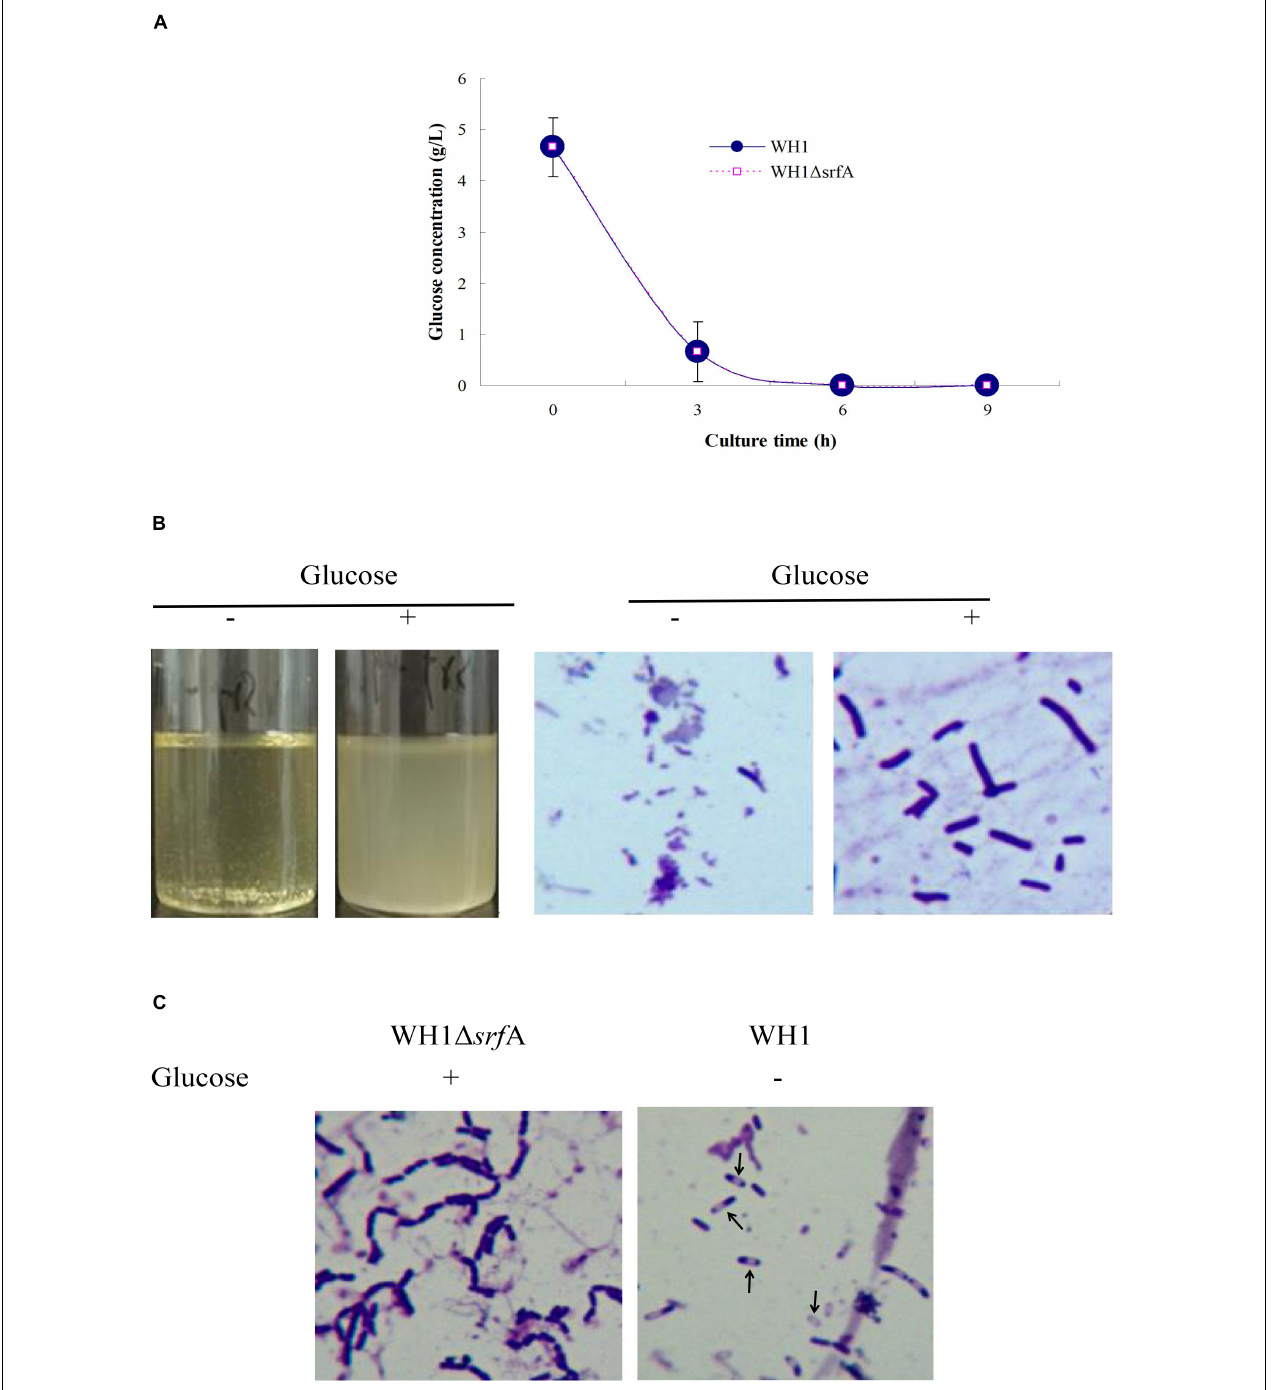
FIGURE 6 | Addition with glucose restored the growth of (cid:49) srfA in LB medium. (A) Residual glucose in LB medium. Both WH1 and (cid:49) srfA showed a similar profile to utilize the glucose in LB medium. (B) Addition with glucose (4 g/L) dramatically restored the growth of (cid:49) srfA in LB medium (magnification 1000 × ). (C) Addition with glucose could not restore the sporulation in (cid:49) srfA (magnification 1000 × ). Spores are indicated by arrows.